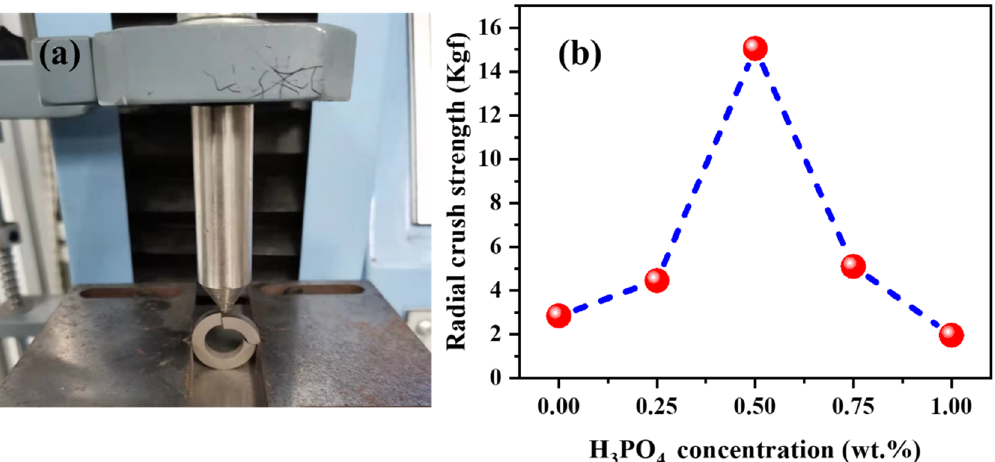
Figure 10. ( a )The radial crush test method and ( b ) the radial crush strength of SMCs based on powders prepared by different H 3 PO 4 concentration followed by 2 wt.% sodium silicate-aqueous solution after annealing.